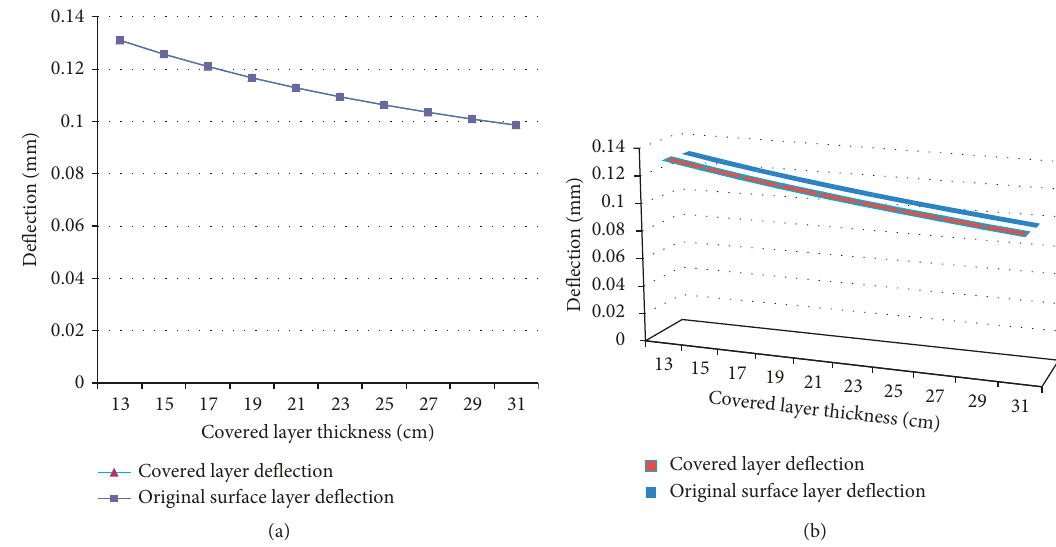
Figure 18: Variation of maximum deflection with covered layer thickness:. (a) two-dimensional broken line graph; (b) three-dimensional broken-line graph.